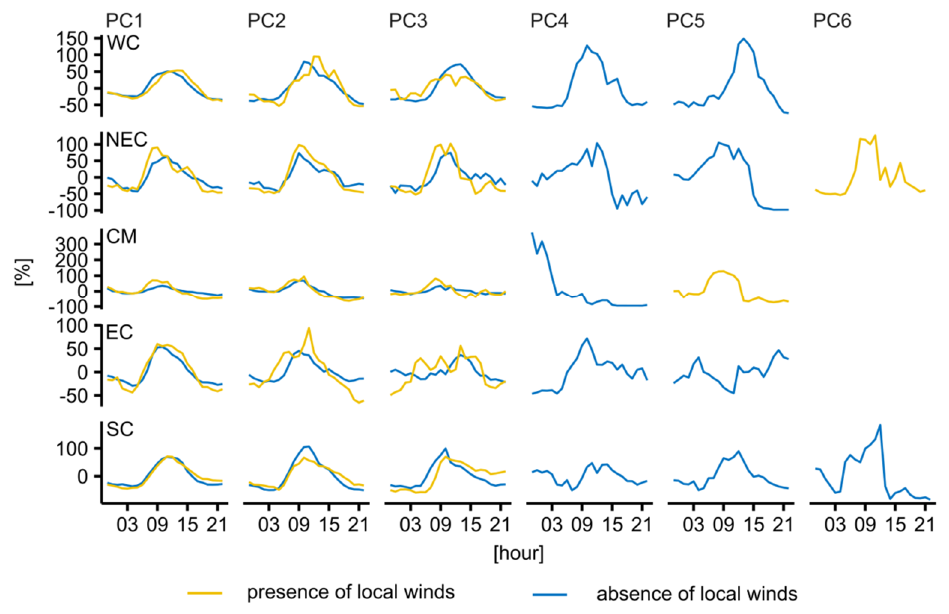
Figure 8. Average water vapor pressure deficit (vpd, hPa) anomaly over the course of the day (in UTC) as a function of the prevailing PC patterns (PC1-PC6) and the occurrence of local winds (yellow (blue) line for the presence (absence) of local winds) on days with SI classified precipitation events. The anomaly is calculated as the difference from the mean vpd of the day within the respective region and displayed as a percentage of the daily average.